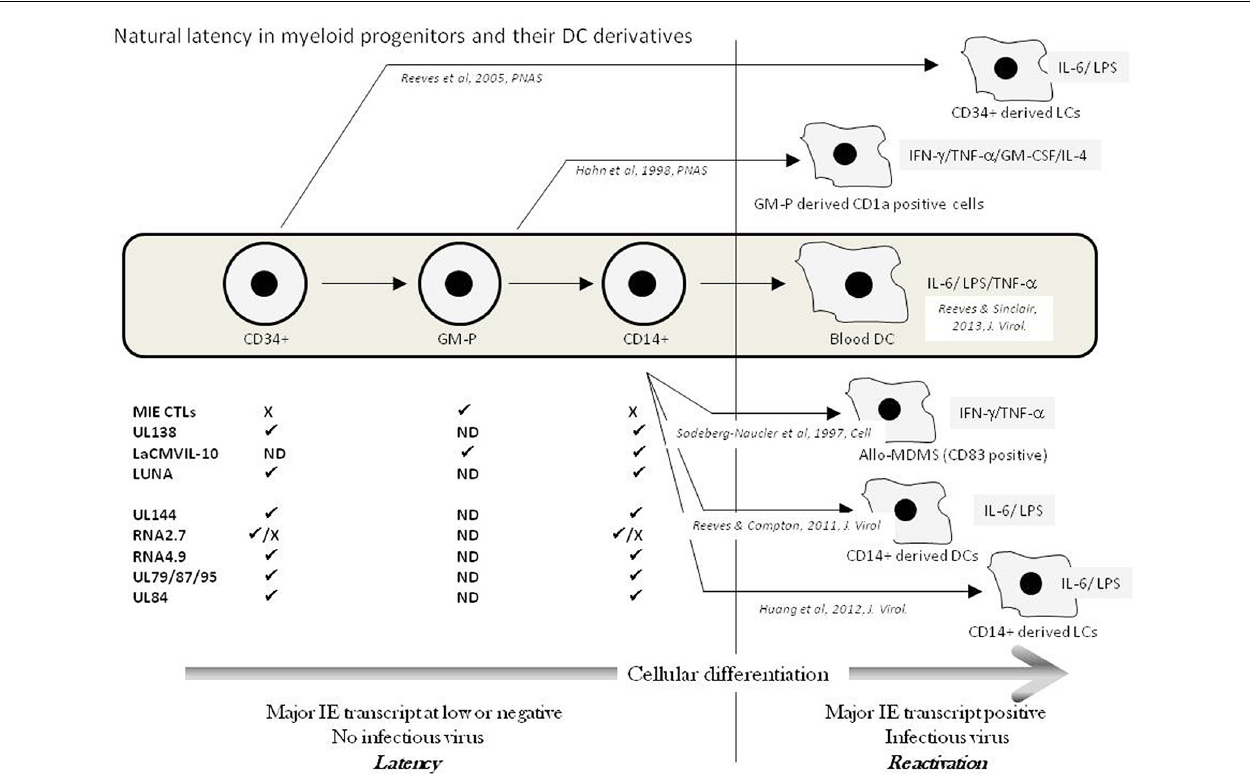
cellular populations ( (cid:2) = detected; X = failure to detect; ND = No Data) and have been suggested to represent putative latent transcripts. Upper transcripts CLTs to LUNA have been verified in multiple laboratories whereas lower transcripts await independent verification.The in vitro differentiation of myeloid progenitors to DC cell types that support HCMV reactivation is shown with the key cytokines implicated in reactivation illustrated from these studies of naturally latent myeloid